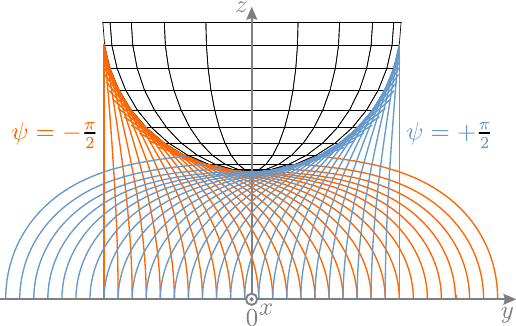
Figure 10. Entirety of solutions for x 0 = 0 with some of the blue ( ψ = + π solutions sharing the same clamping position P 0